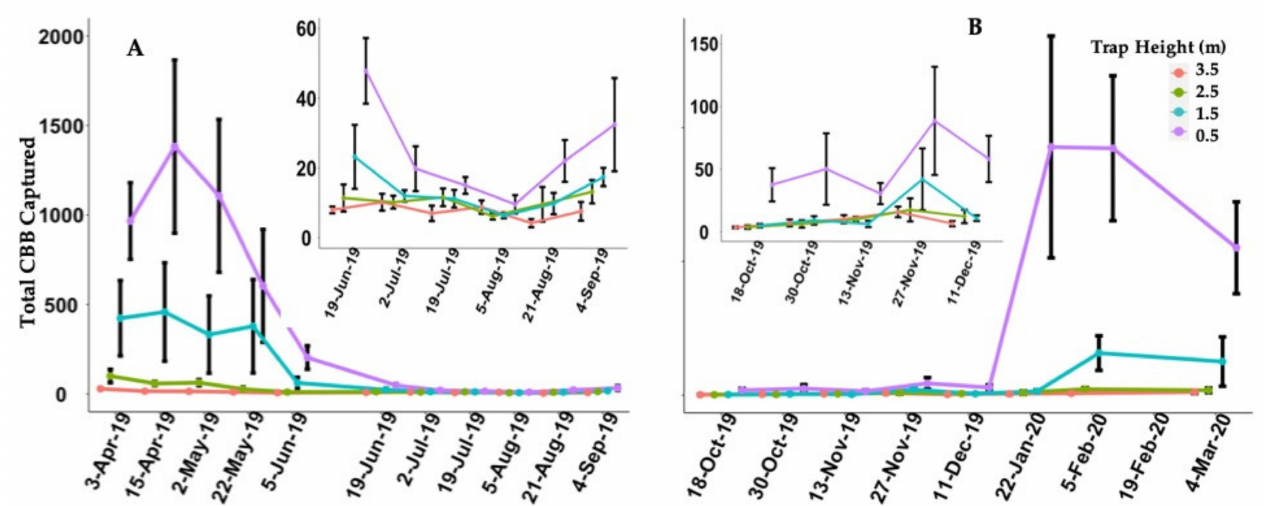
Figure 3. ( A ) Average and standard error per collection date for each height of the Column Traps over the time of Experiment A. ( B ) Average and standard error per collection date for each height over the time of Experiment B, Adjuntas, Puerto Rico. At the top, there is a close-up of CBB catches in the period when the catch decreases. However, the Column Traps follow the same pattern of catches by height: the lower the height, the greater the CBB